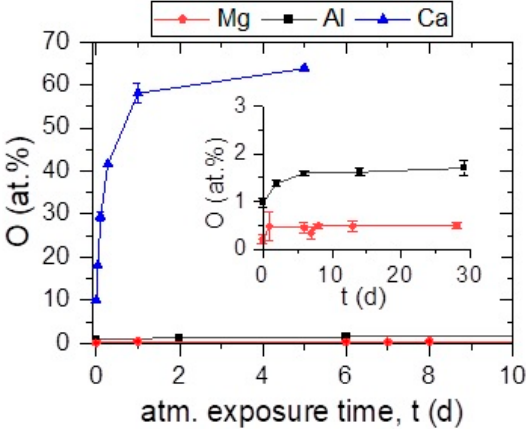
Figure 4. O concentration measured by EDX in Mg (base pressure = 6.1 × 10 − 6 Pa), Al (base pressure = 8.2 × 10 − 6 Pa), and Ca (base pressure = 6.5 × 10 − 6 Pa) thin films synthesized at 100 °C as a function of their atmosphere exposure time after synthesis (expressed in days (d)). Atmosphere exposure time of 0 days corresponds to the as-deposited state ( ≤ 3 min atmosphere exposure). Thin film delamination was observed in case of Ca after 5 days preventing further analysis.